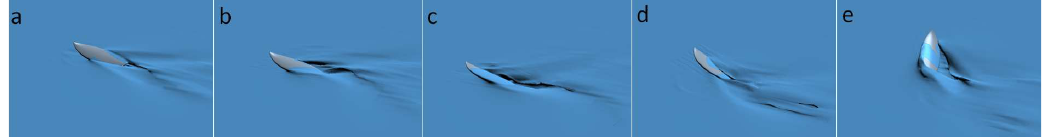
Figure 4. Snapshots of the free surface behind the board at different moments in the maneuvering simulation.